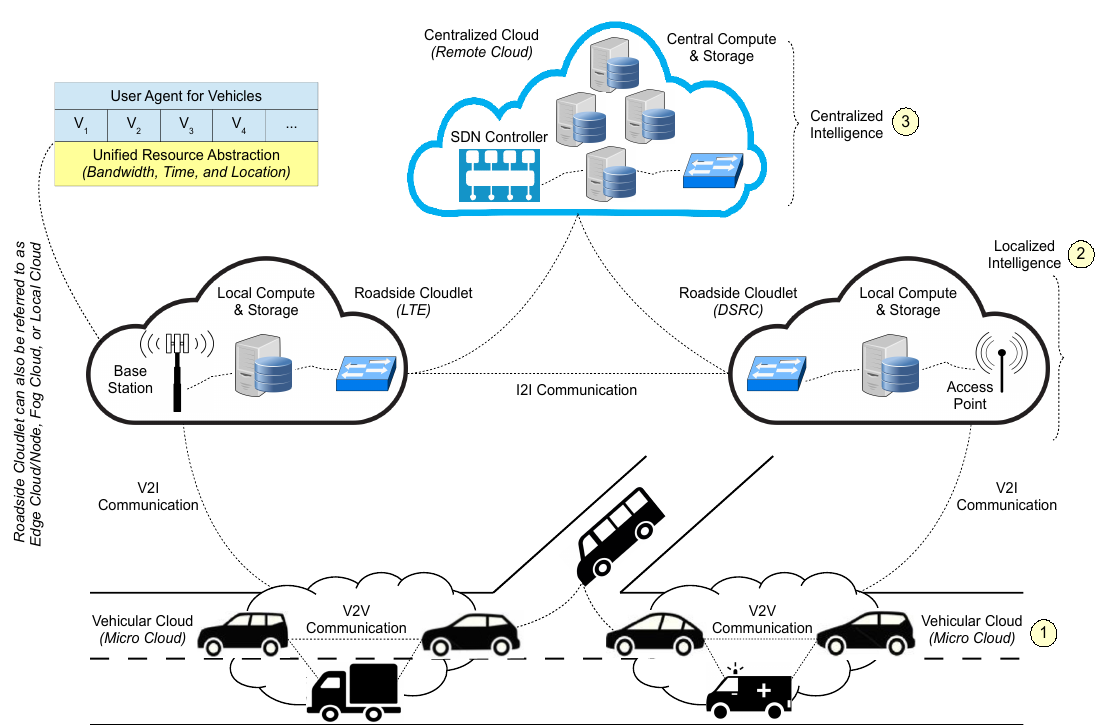
Figure 4. A topological architecture of software-defined heterogeneous vehicular network